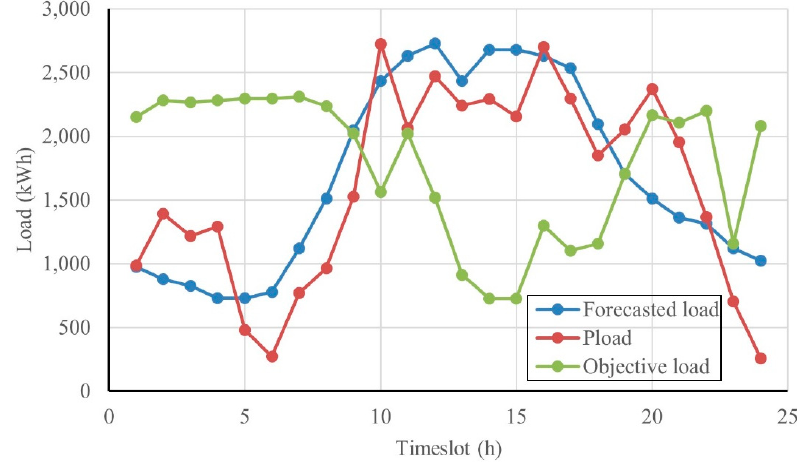
Figure 6. Hourly commercial load before and after shifting using TOU-PSO.